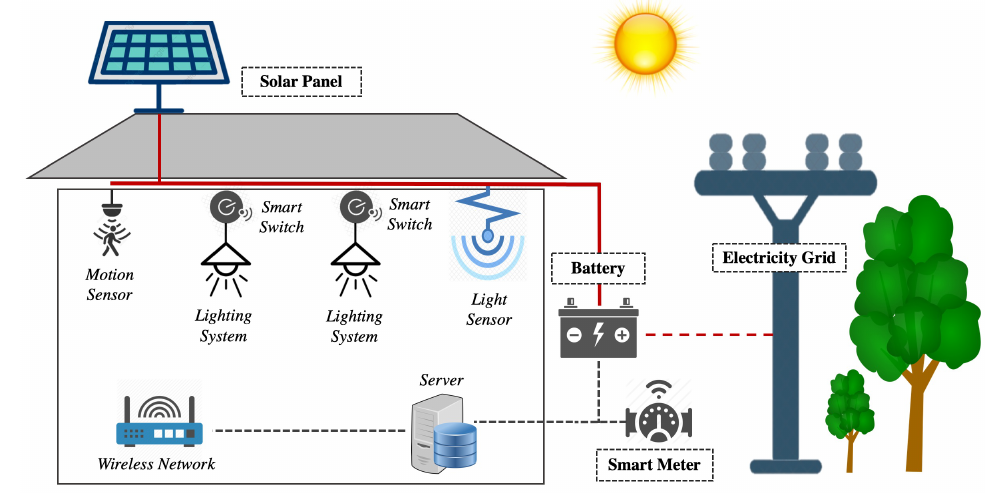
Figure 1. The concept of IoT-enabled building energy management